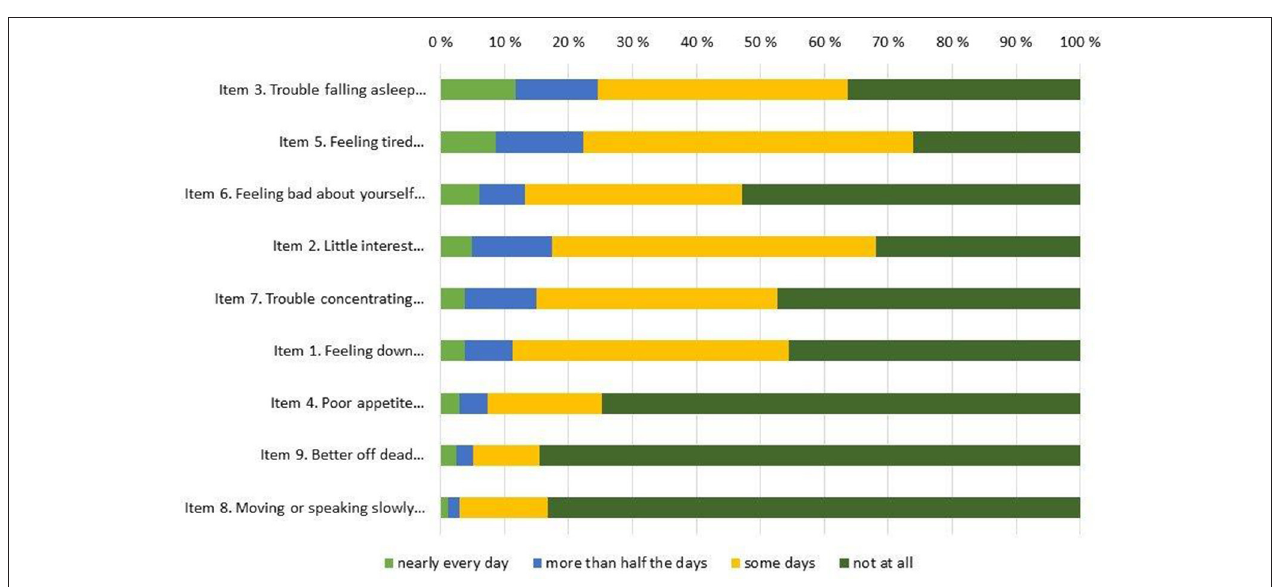
FIGURE 1 | PHQ-9 item response frequency distribution total